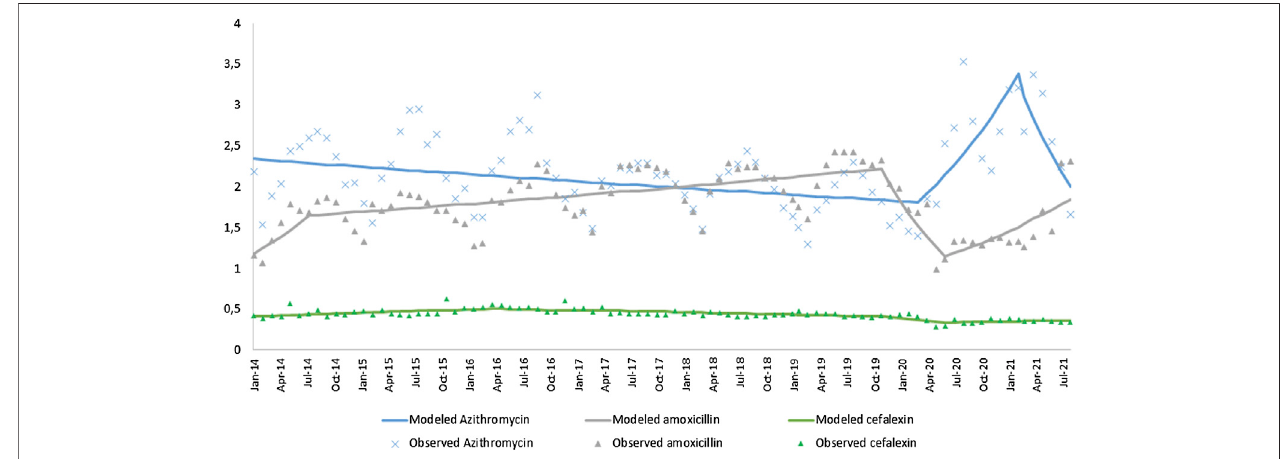
FIGURE 2 | Observed and modeled monthly consumption (DDDs) of the antibiotics studied, with changes in trends (Joinpoint).